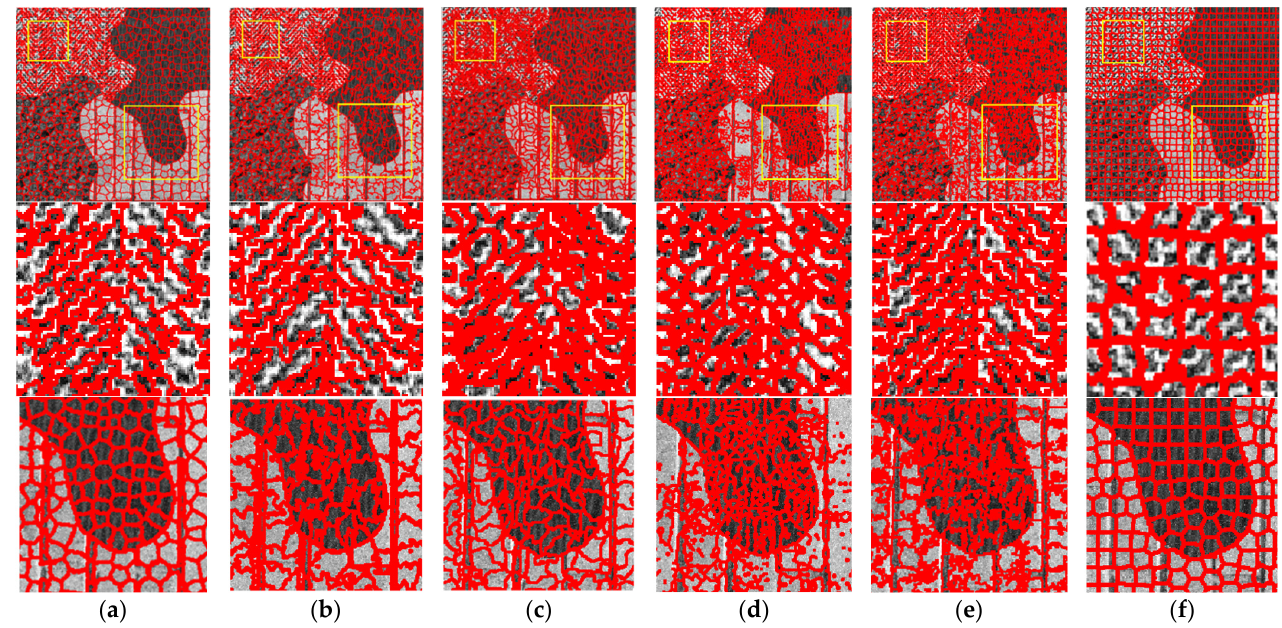
Figure 16. Superpixel generation results for the image SI 2 . The pictures in the second and third lines show the details in the yellow square in the pictures of the corresponding first line. ( a ) SLIC, ( b ) SNIC, ( c ) SEEDS, ( d ) SPAMP, ( e ) CAS, and ( f ) EDTRS.